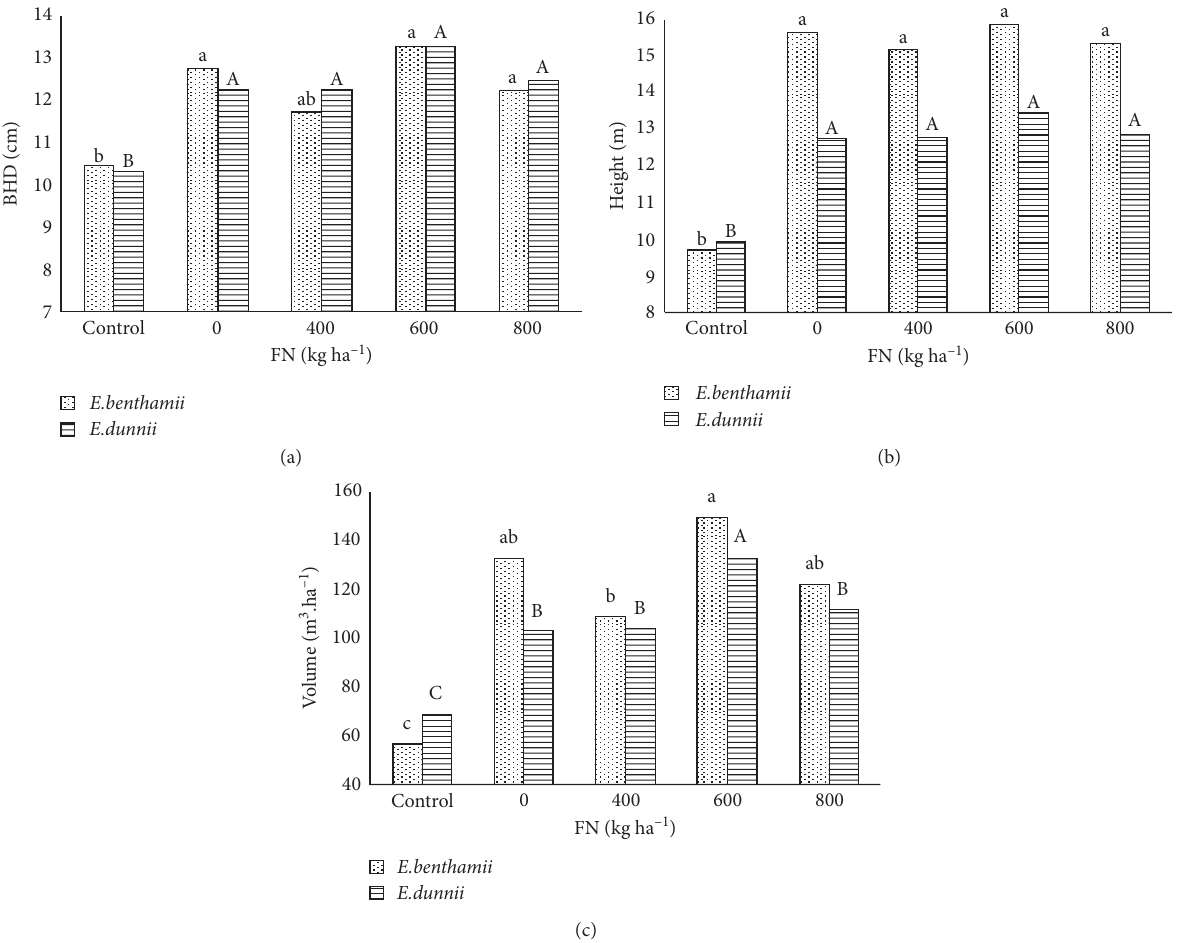
Figure 2: (a) Breast height diameter (BHD, cm), (b) height (m), and (c) volume (m3 ha − 1 ) in Eucalyptus benthamii and Eucalyptus dunnii in relation to natural phosphate (FN) fertilizing. Averages followed by the same letter, lower and uppercase, do not differ between them by the Tukey test at 5% probability. Lowercase letters compare fertilization in relation to E. benthamii . Uppercase letters compare fertilization in relation to E. dunnii